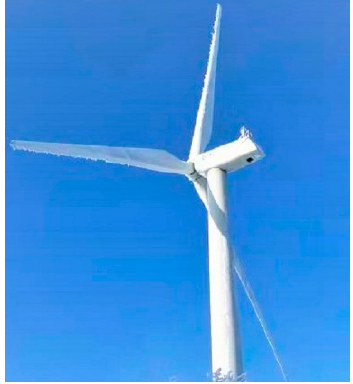
Figure 1. Icing on wind turbine